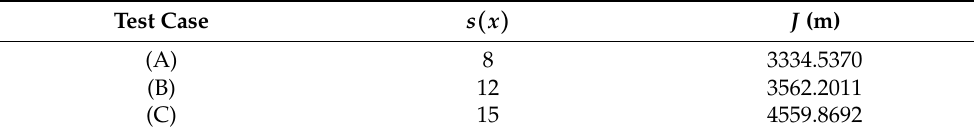
Table 4. RRT*-Smart results for test cases (A), (B) and